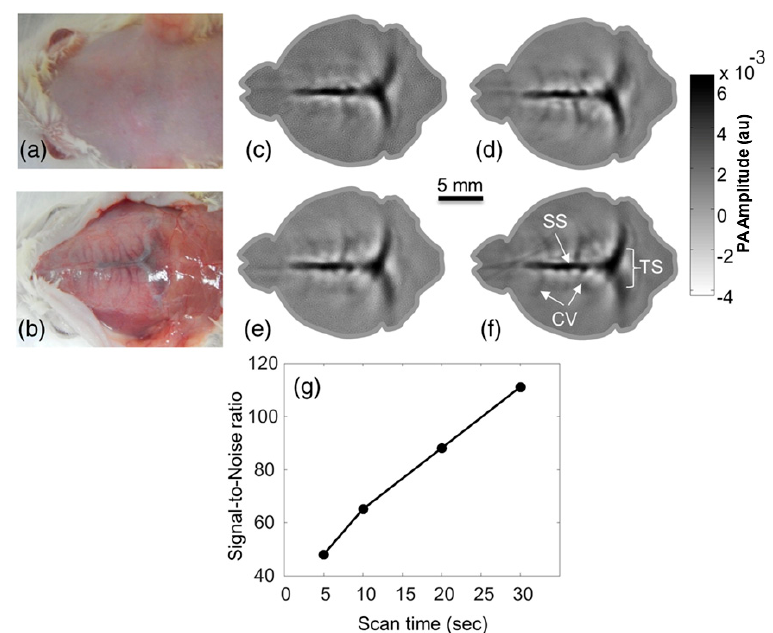
Figure 17. Images of brain vasculature in a 95 g female rat acquired non-invasively with a laser diode-based photoacoustic tomography system at different scan times: photograph of rat brain before ( a ) and after ( b ) removing the scalp. In vivo brain images at a ( c ) 5-s, ( d ) 10-s, ( e ) 20-s, and ( f ) 30-s scan time. ( g ) SNR of the in vivo images as a function of scan time. SS, sagittal sinus; TS, transverse sinus; CV, cerebral veins. Adapted with permission from P. K. Upputuri and M. Pramanik, Journal of Biomedical Optics, Vol.22, Article ID090501, 2017; licensed under a Creative Commons Attribution